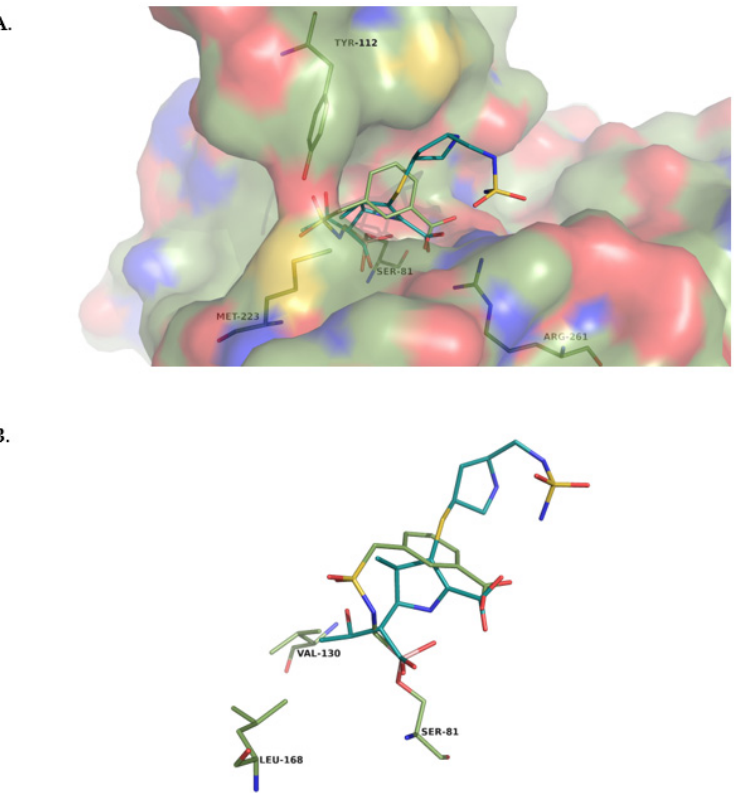
Figure 3. ( A ) Superposition of OXA ‐ 24/40 in complex with CR167 (smudge green) and doripenem (slate; 7RPF). Ligands are indicated as sticks. The R2 region is located to the right of the bridge formed by Tyr112 and Met223 and offers space for optimization of inhibitors. ( B ) Close ‐ up of the hydroxyethyl group of doripenem and the hydrophobic pocket. Nitrogen atoms are colored blue, oxygens red, sulfurs yellow, and borons pink. This and all subsequent figures were made with PyMOL (Schrodinger, LLC).